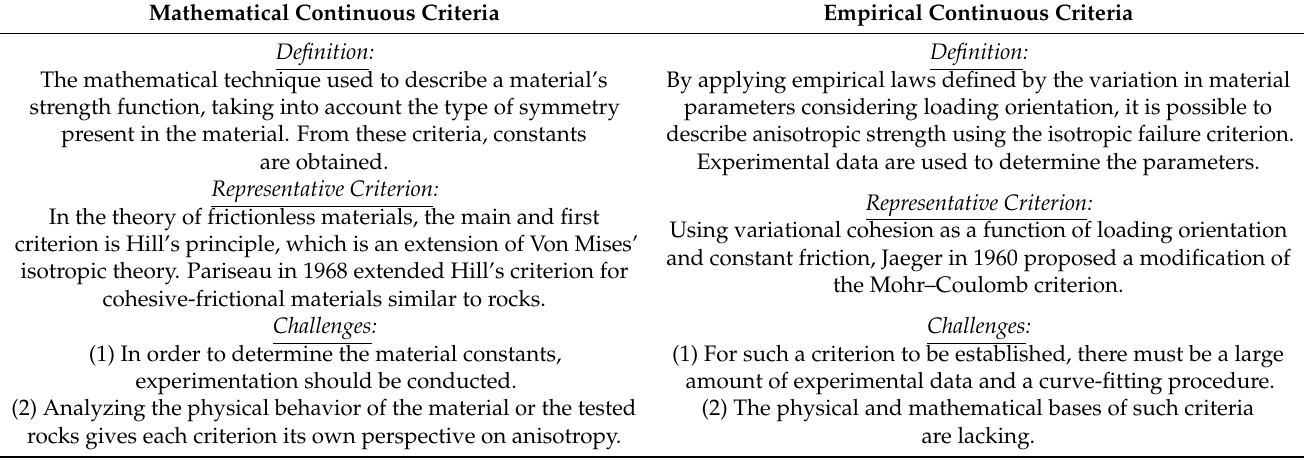
Table 22. Mathematical and empirical continuous criteria